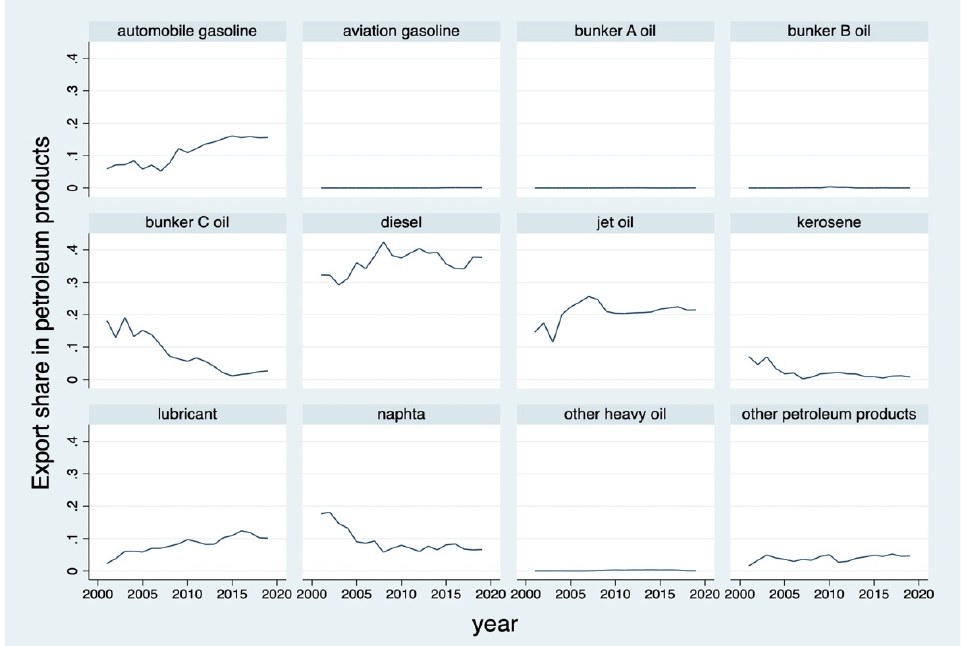
Figure 1. Trend of export share by petroleum product.